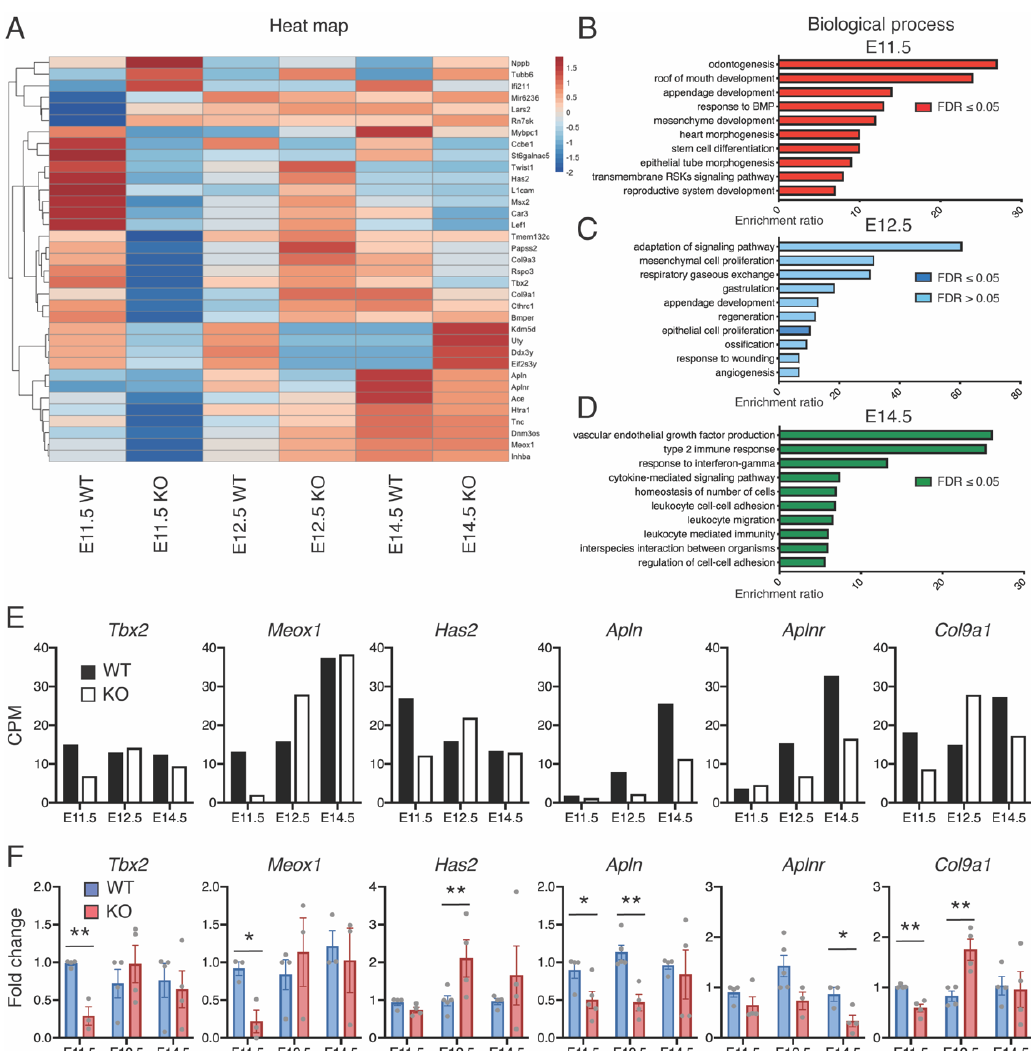
Figure 7. Ccbe1 KO hearts exhibit deregulation of expression of EMT- and coronary development- related genes. ( A ) Heatmap of differentially regulated genes in Ccbe1 tm1Lex ventricles at E11.5 ( n = 3), E12.5 ( n = 3), and E14.5 ( n = 3) as compared to wild-type hearts ( n = 3, respectively). ( B – D ) GO functional enrichment of DEGs in Ccbe1 KO ventricles at E11.5 ( B ), E12.5 ( C ), and E13.5 ( D ). ( E ) Gene expression for differentially expressed genes. ( F ) qRT-PCR validation. * p < 0.05; ** p < 0.01. Differences were considered statistically significant when * p < 0.05. Error bars represent SDs. CPM, counts per million reads mapped.